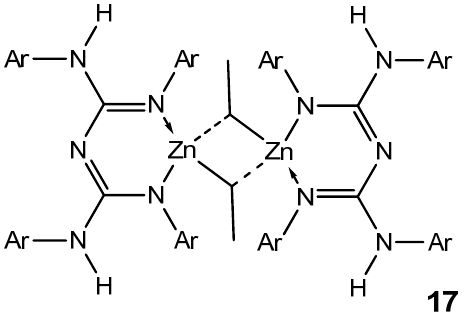
Figure 12. Bis-guanidianato alkyl zinc dimeric complex.